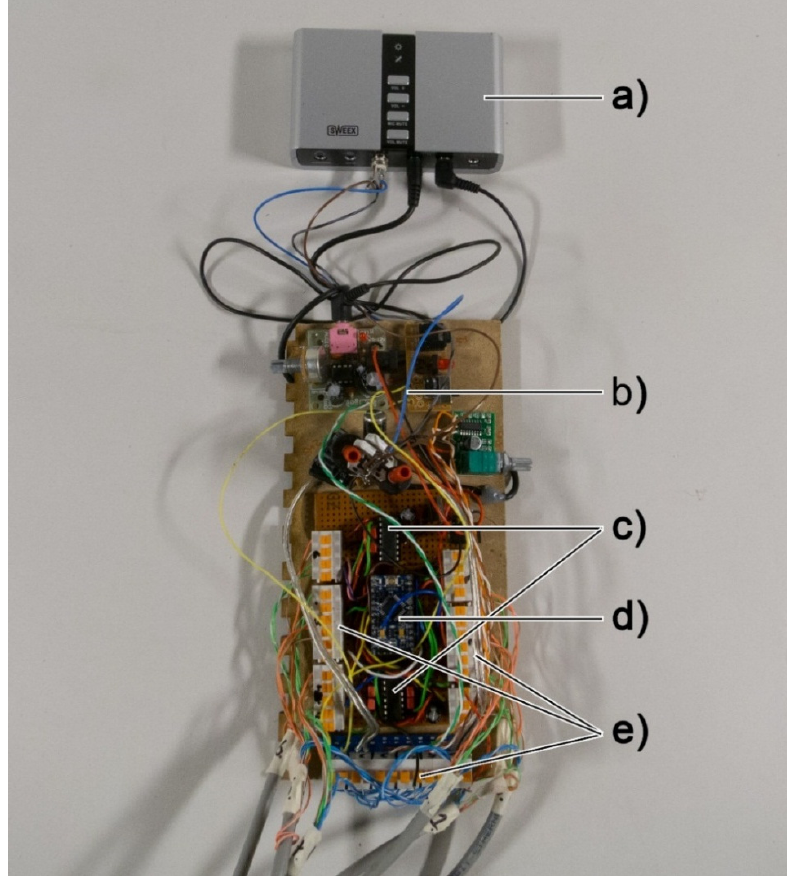
Figure 9. Prototype control board with Sweex 7.1 sound card ( a ); assorted 1–3 W amplifiers ( b ); L298N H-bridge motor controller ( c ); Arduino Pro Mini ( d ); and terminals ( e